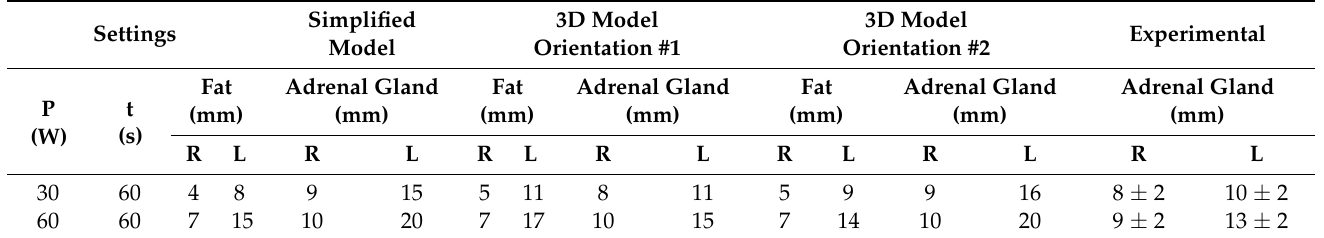
Table 3. Radial and longitudinal extents calculated at 30 W (first line) and at 60 W (second line) in the simplified geometry and in the 3D model, in the case of 5.8 GHz. The radial and the longitudinal dimensions of ablation zones measured experimentally are reported in terms of mean and standard deviation for each power and time setting